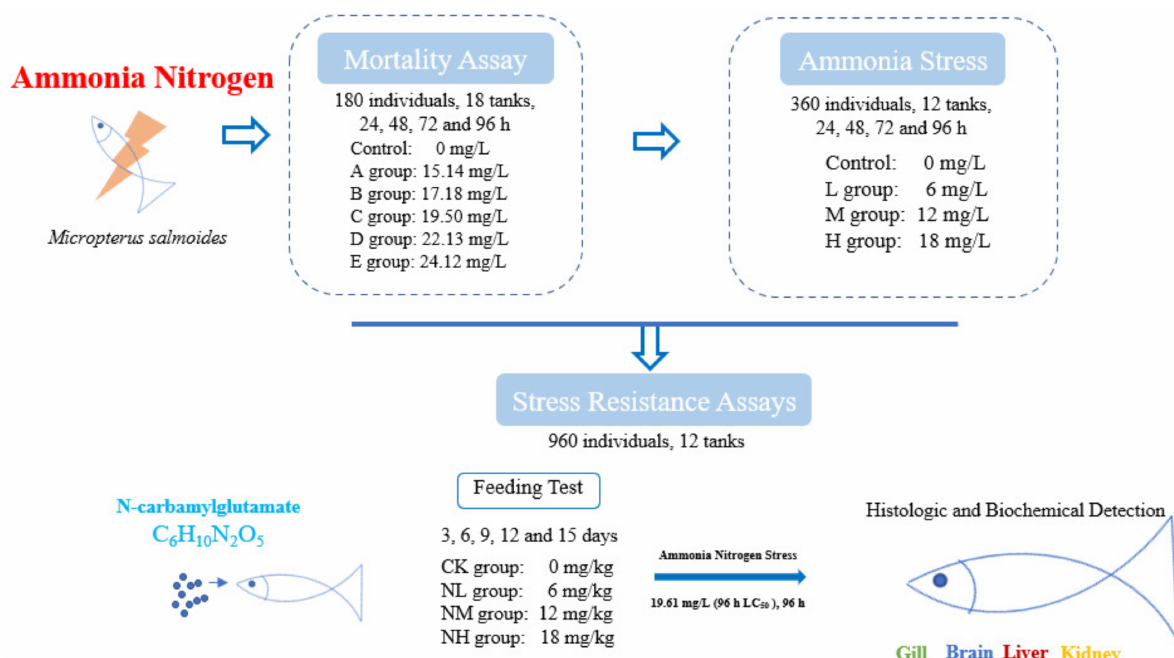
Figure 1. Overview of treatment and sample collection in this